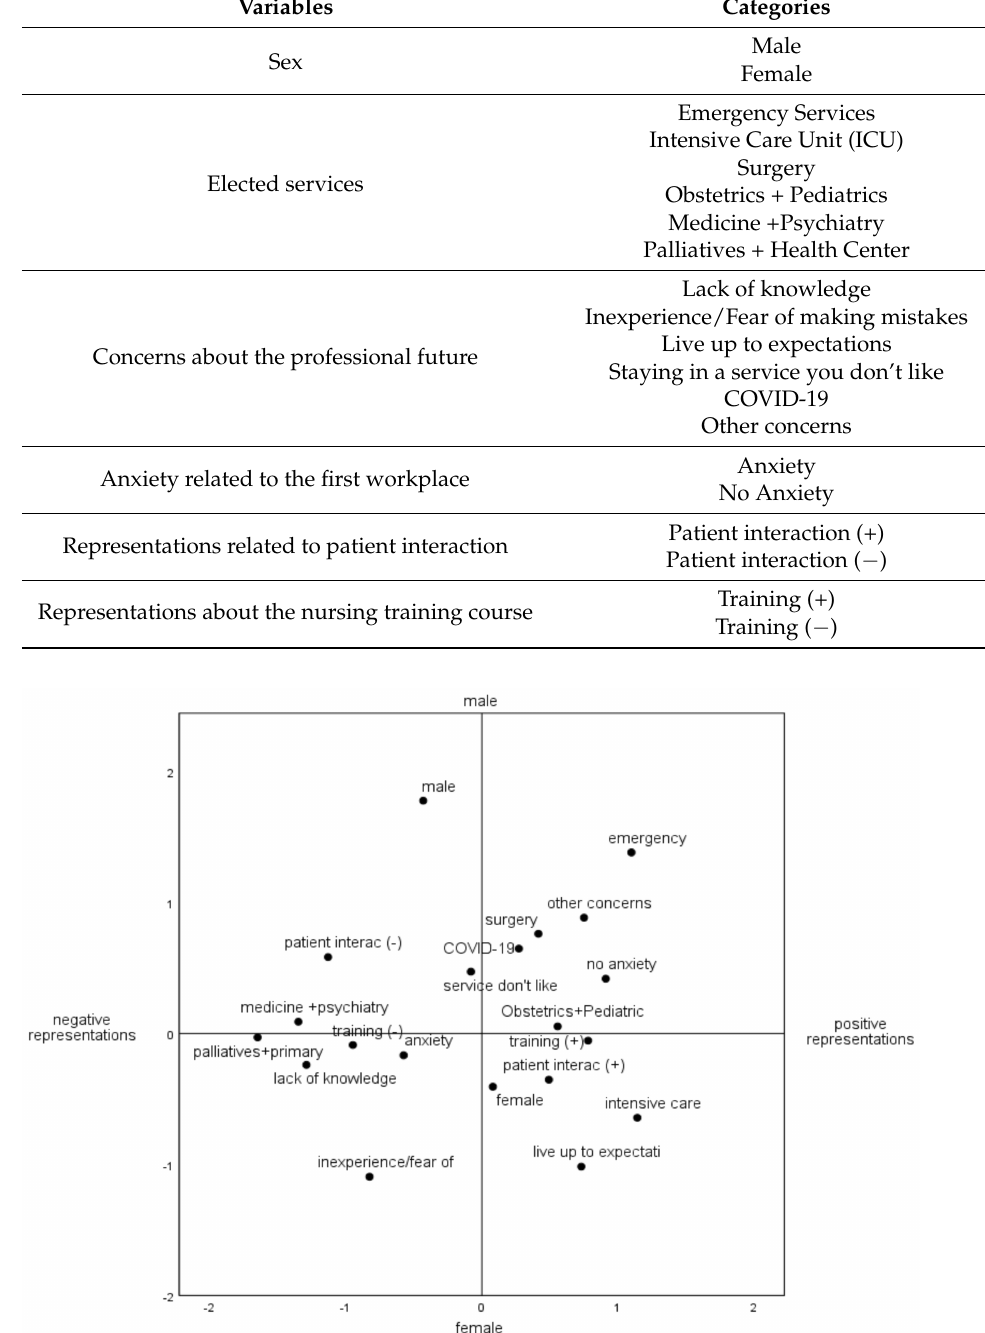
Figure 1. Representations of nursing students in the period of transition to the